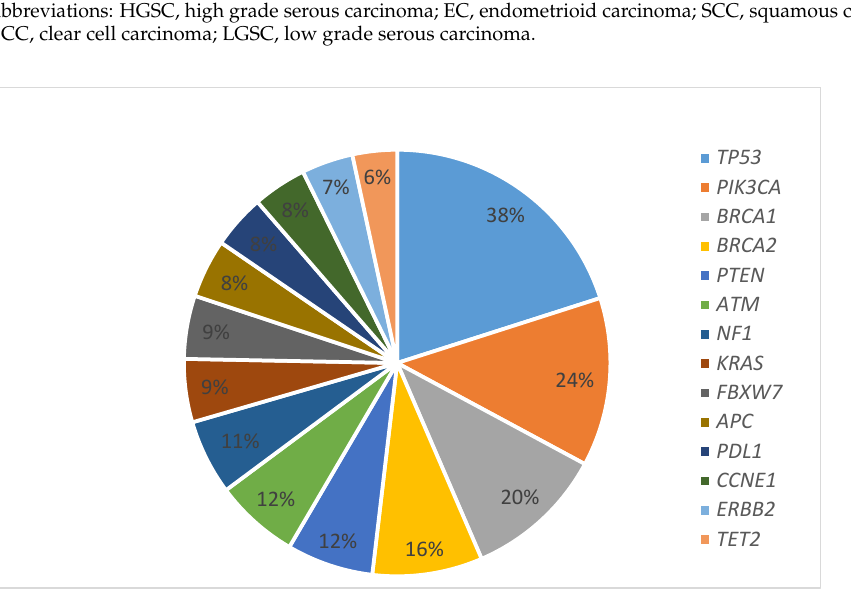
Figure 1. Genes most frequently altered in our cohort (The number of alterations ranged from 0 to 25 with a mean of 2.8 per case).